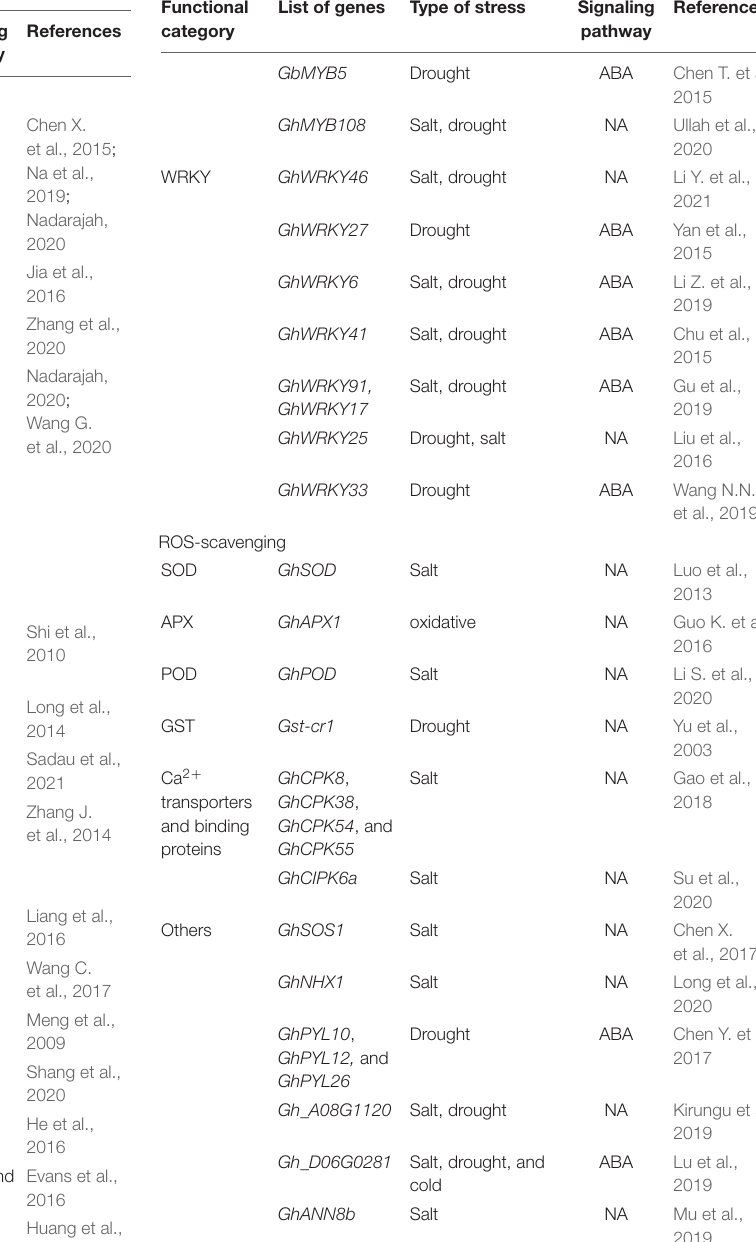
TABLE 1 | Summary of cotton genes regulatory networks in response to salt and